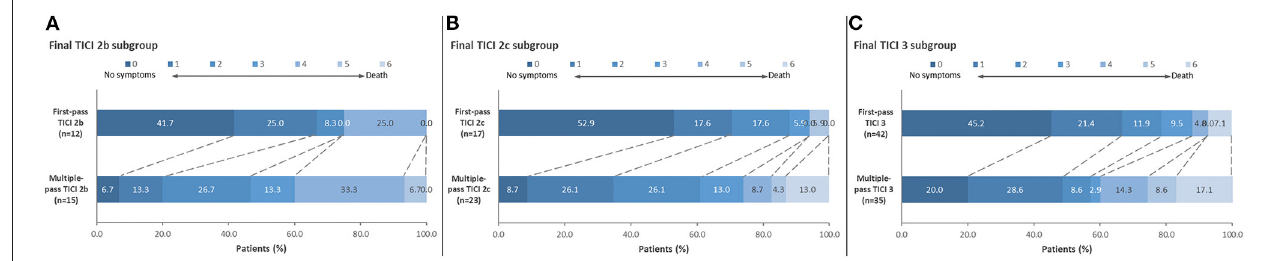
FIGURE 1 | Distribution of 90-day mRS scores comparing first-pass reperfusion vs. multiple-pass reperfusion. Results are shown for (A) final TICI 2b: median 90-day mRS scores were 1 (IQR 0-3) vs. 3 (IQR 2–4) for the first-pass group vs. the multiple-pass group ( P = 0.04); (B) final TICI 2c: median 90-day mRS scores were 0